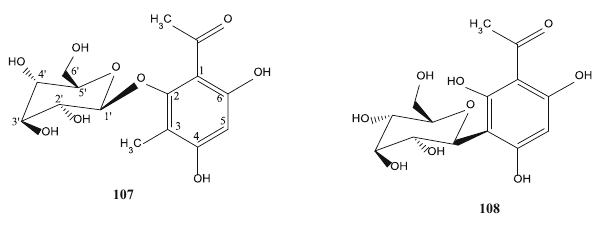
108107 Figure 9: Phenyl glycosides of S. aromaticum